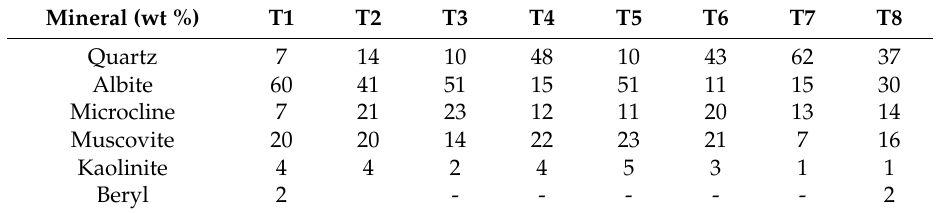
Table 2. Semi-quantitative mineral composition of the product tailings determined by XRD.